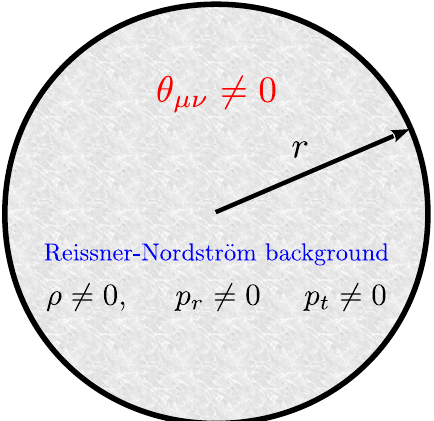
Fig. 1 Spherical symmetric space-time covered with two contribu- tions: (i) the Reissner–Nordström background and (ii) the source θ ν μ . Of course, the case θ μν → 0 yields the anisotropic black hole